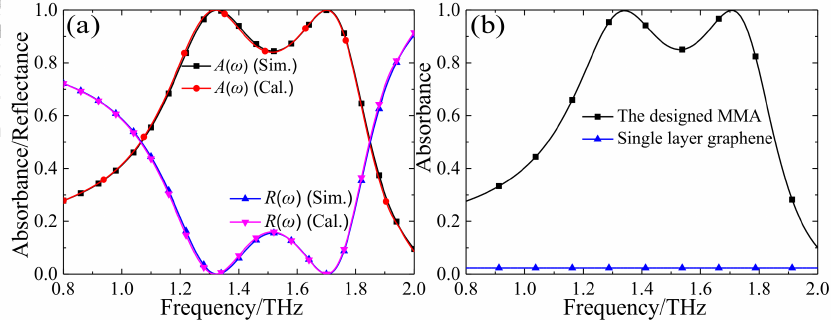
Figure 2. The numerical results of the proposed MMA with µ c = 0.5 eV: ( a ) the simulated and calculated reflectance and absorbance of the designed MMA based on CCOSG sheet; ( b ) the simulated absorbance of the MMA based on CCOSG sheet and bare mono-layer